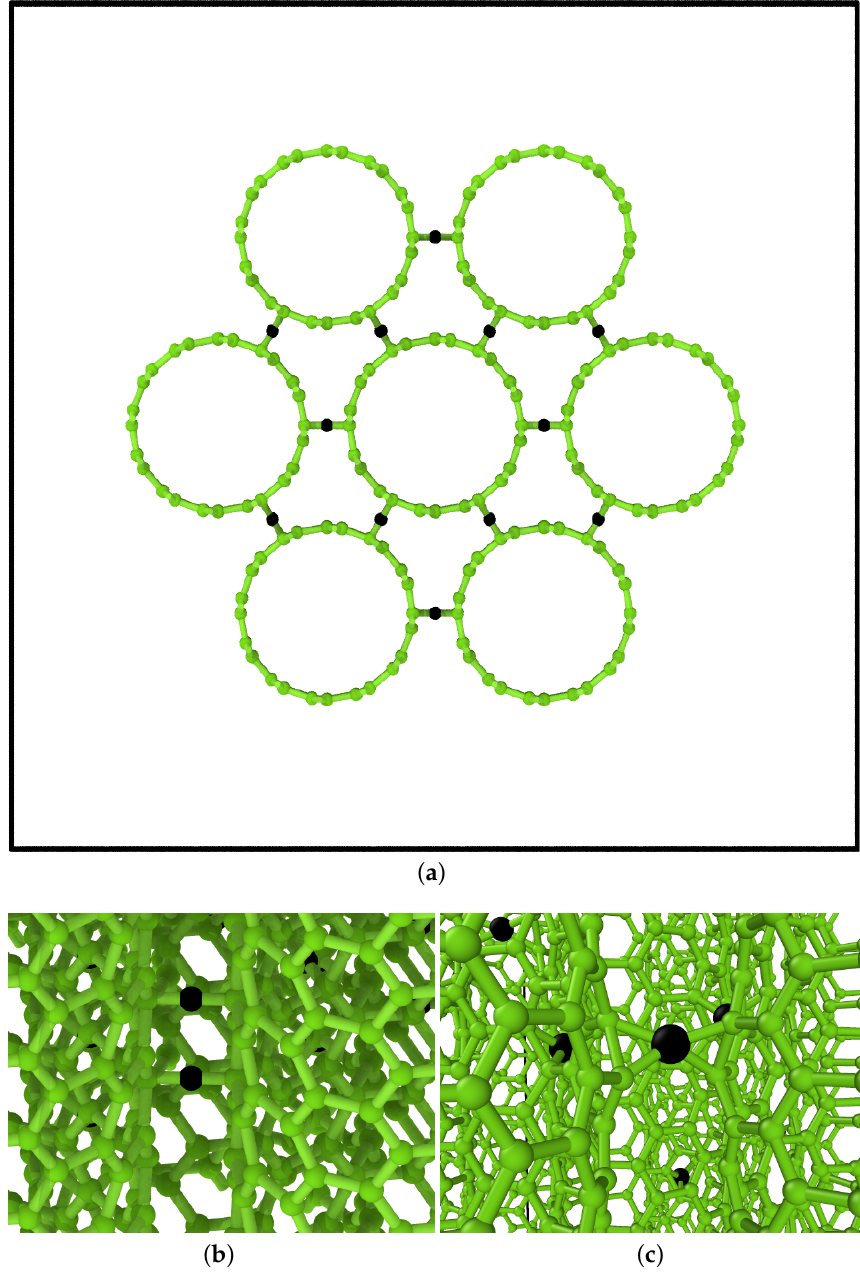
Figure 1. Computational model of the (6,6) CNT bundle ( a ), showing the hexagonal symmetry of the structure; the symmetry was exploited to insert the linkers (rendered in black). The linkers are covalently bonded with the nanotubes ( b ). Upon relaxation, they form tetravalent bonds ( c